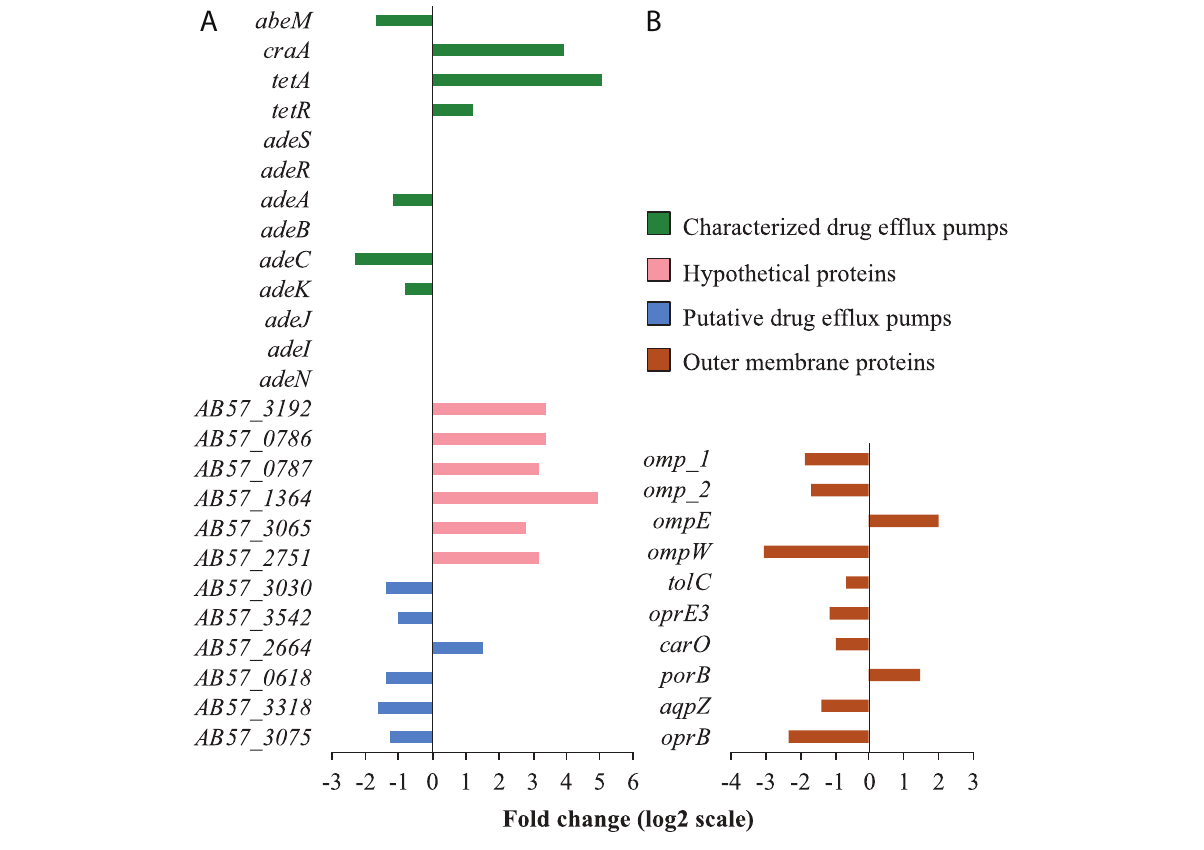
FIGURE 4 | Tigecycline impact on the transcription of genes involved in membrane permeability and transport. (A) The characterized drug efflux pumps presented here are either the ones differentially regulated, or the ones known in conferring tigecycline resistance. The hypothetical proteins are responsive to tigecycline and predicted to have transmembrane helixes. (B) Only the differentially regulated OMPs are presented. All the genes on the panel (A,B) have absolute fold change more than 1 (log 2 scale) with statistical significance (padj < 0.01). Full information on gene function annotations is given in Supplementary Data